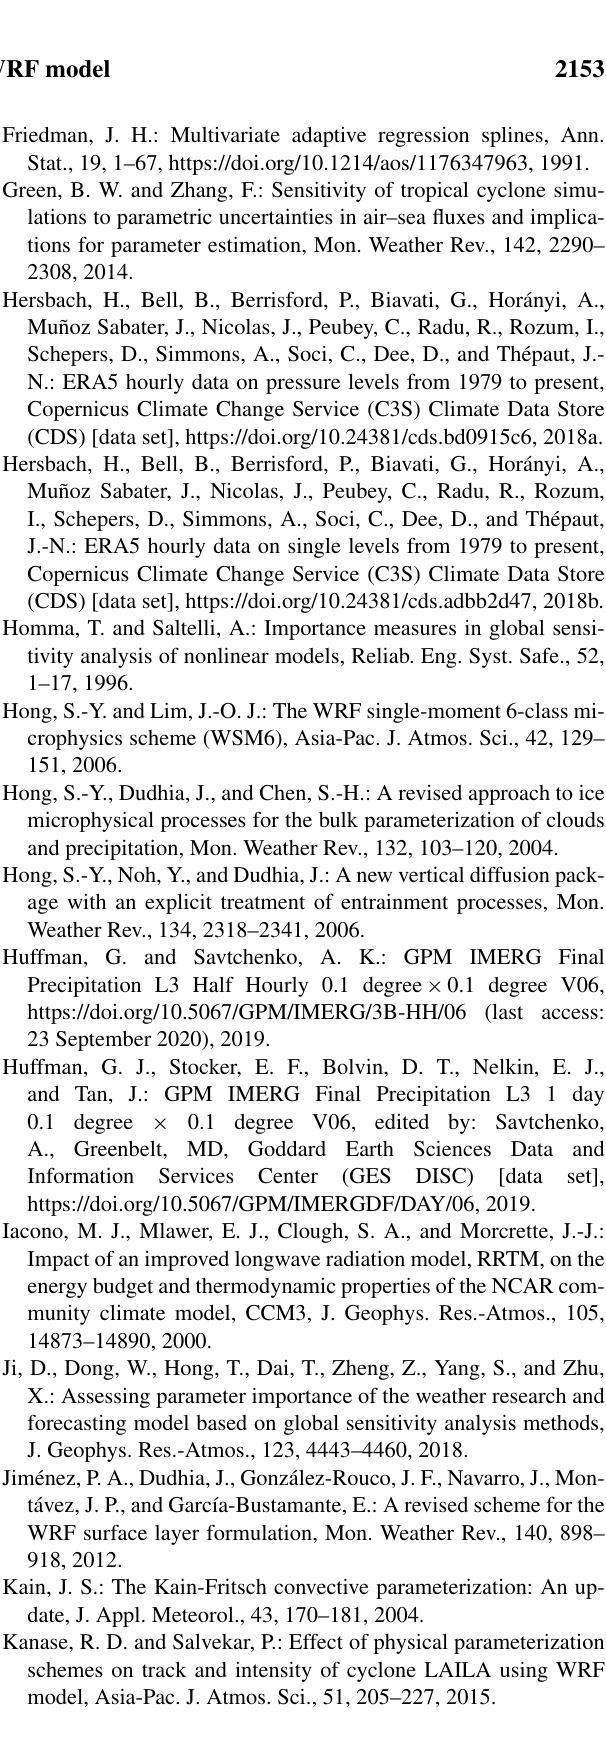
APIs. The figures are plotted using the Python language and NCAR Command Language